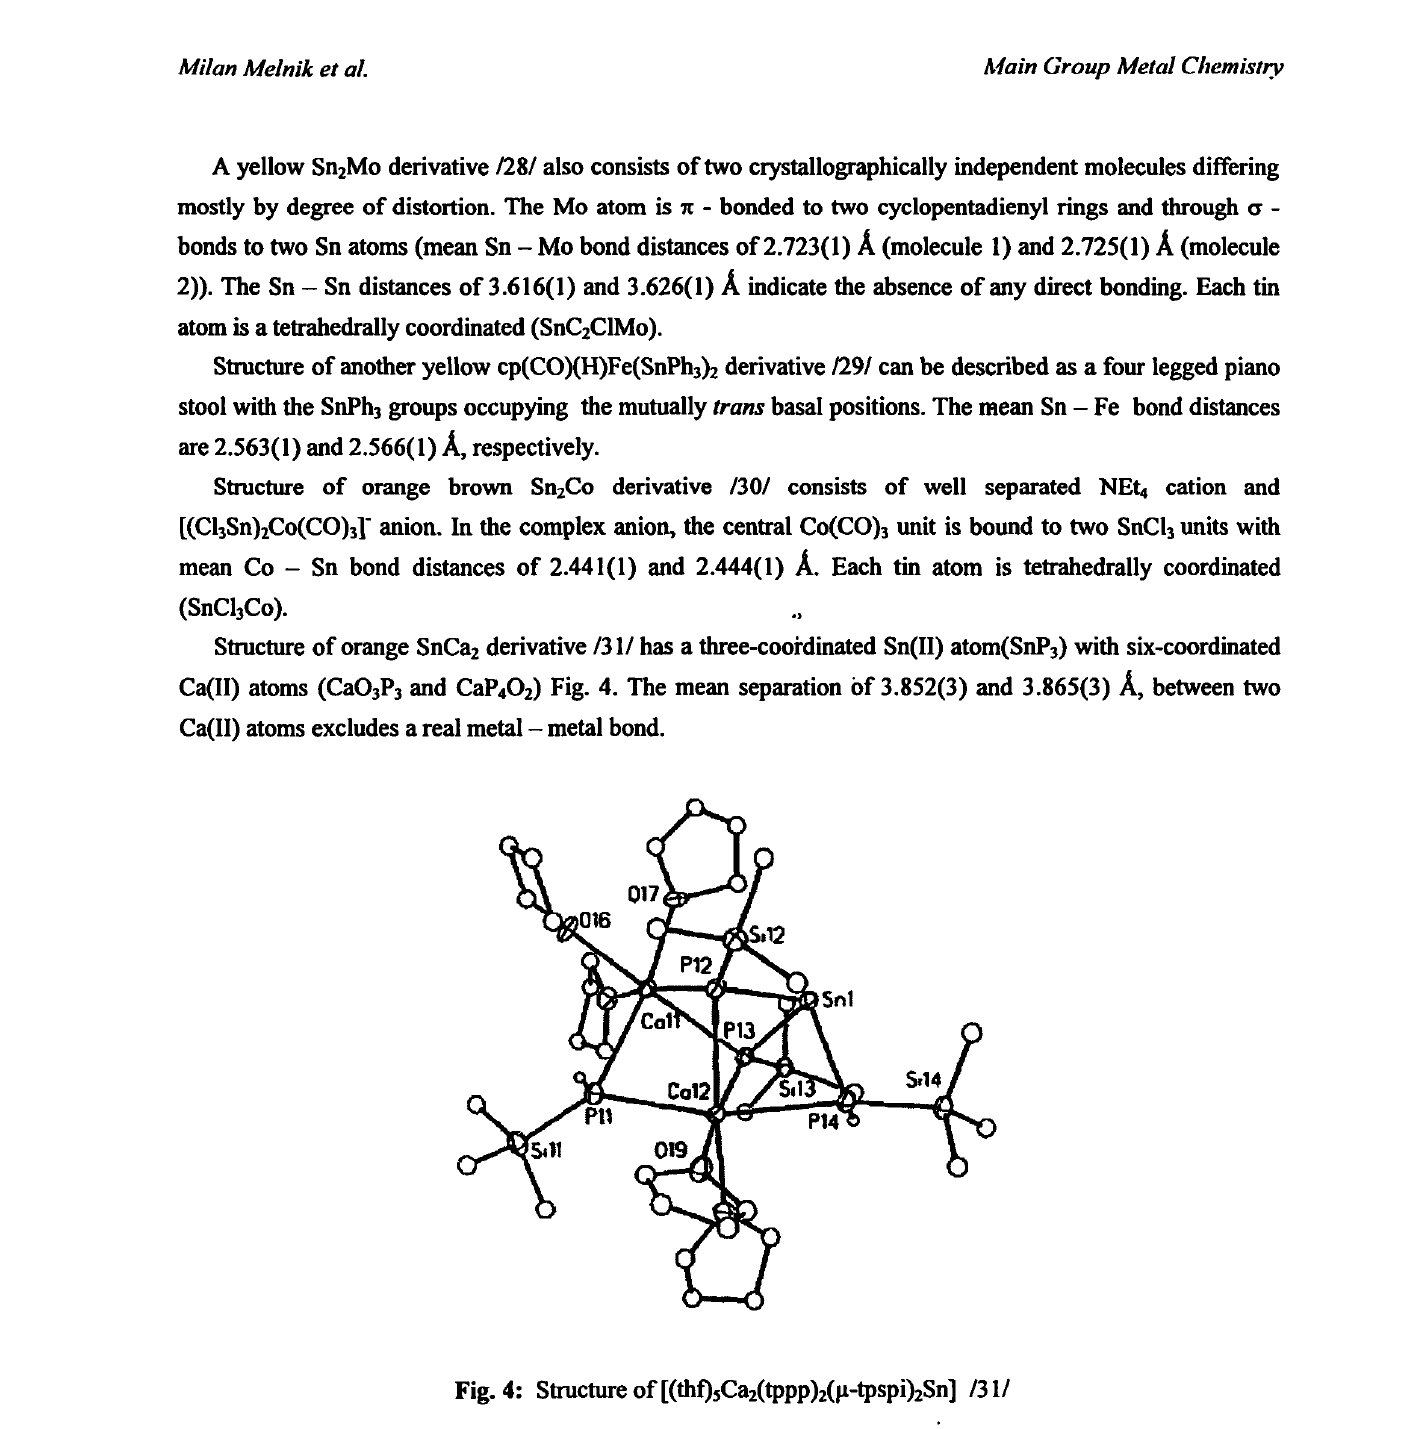
(tppp) ^-tpspi) Sn] 2 2 2